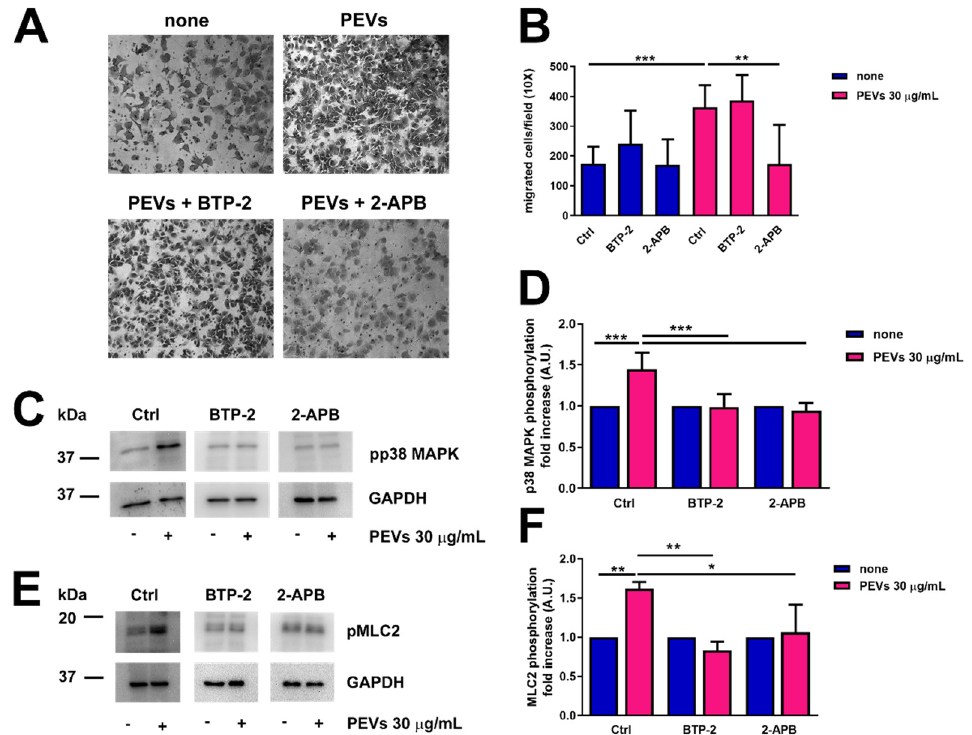
Figure 7. Pharmacological blockade of InsP 3 Rs with 2-APB significantly inhibited migration in MDA-MB-231 cells treated with PEVs. ( A ). MDA-MB-231 cells were incubated with PEVs (30 µ g/mL, 24 h) or left untreated (none) before being treated with 2-APB (50 µ M) and BTP-2 (20 µ M) and then transferred into cell culture inserts. The cells migrated through the porous membrane were stained and counted. Representative images of migrated stained cells are reported. The quantification of the results is shown in ( B ) as the mean ± SD of three experiments. ** p < 0.01 and *** p < 0.005. Phosphorylation of p38MAPK ( C , D ) and MLC2 ( E , F ) in MDA-MB-231 cells incubated with PEVs (30 μ g/mL, 24 h) and then treated with 2-APB (50 μ M) and BTP-2 (20 μ M). Representative immunoblots are reported in ( C , E ) for phospho-p38MAPK and phospho-MLC2, respectively, where GAPDH staining is for equal loading control. The quantification of the results is shown in ( D ) for phospho-p38MAPK and in ( F ) for phospho-MLC2 as the mean ± SD of three experiments. * indicates p < 0.05, ** indicate p < 0.01 and *** indicate p < 0.005.